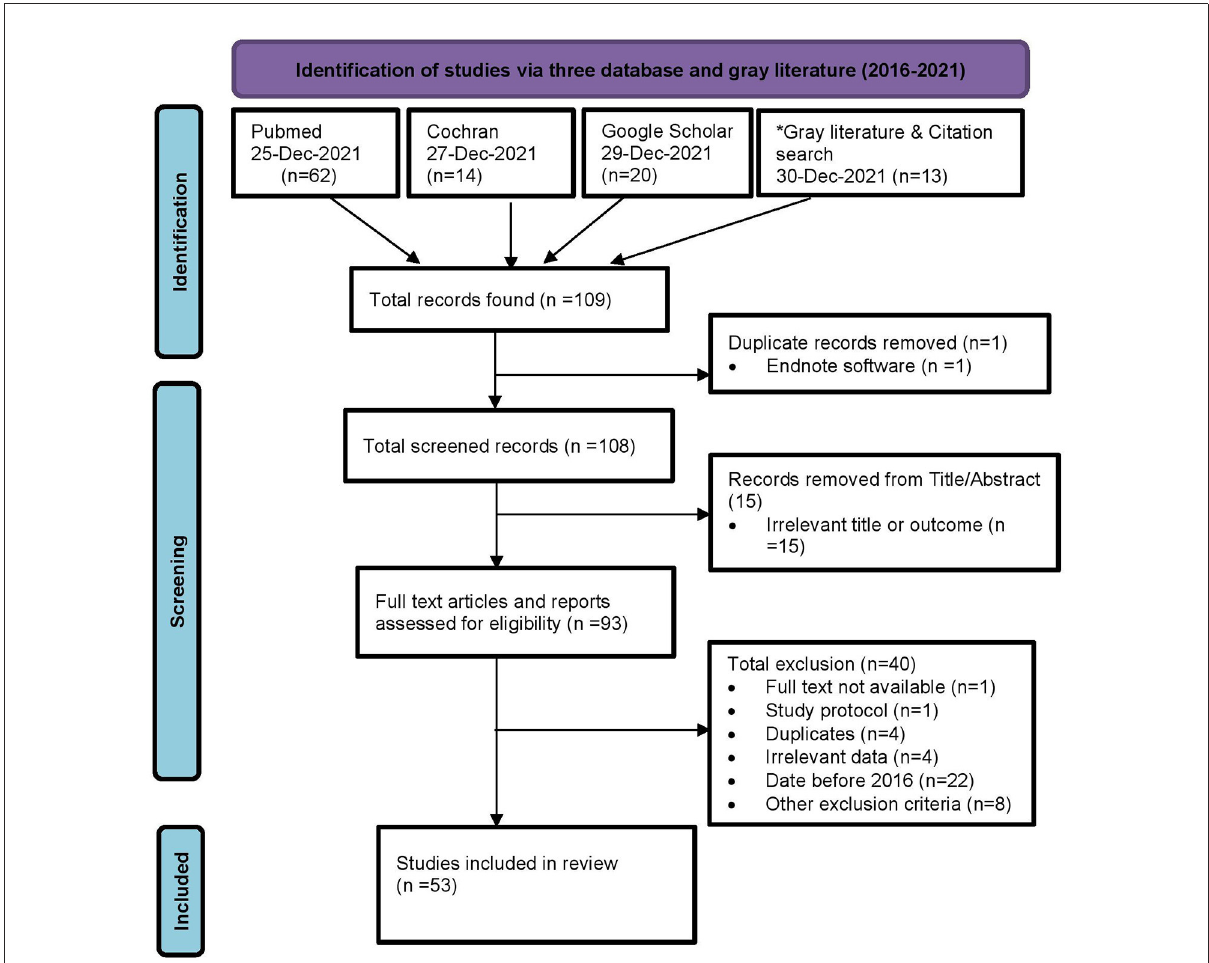
FIGURE1 PRISMA chart of screening and included studies. * Gray literature search includes Shahid Gangalal National Heart Center (2), Mrigendra Samjhana Medical Trust (MSMT) (1), National Health Research Council (2), Ministry of Health and Population, Dept. of Health Services (3), Others (3), and Citation search